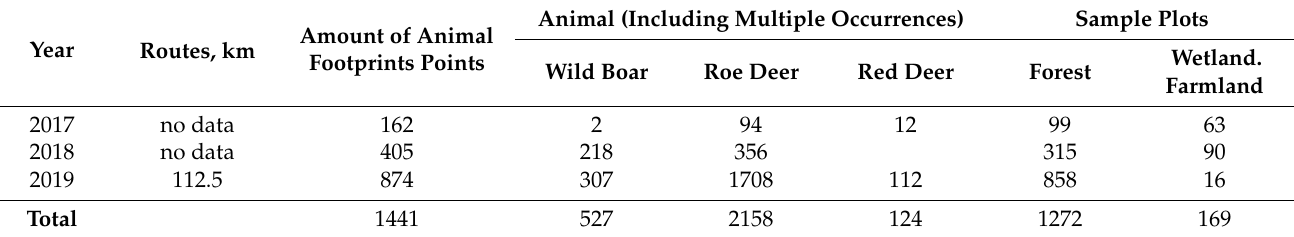
Table 2. Animal census in sample plots (amount of data was collected in the